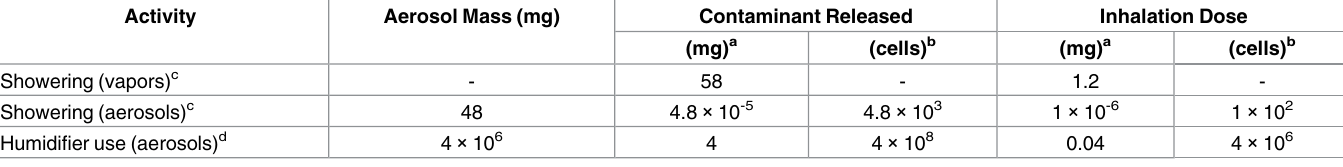
Table 6. Illustrative Potential Inhalation Doses from Showering and Humidifier Use.